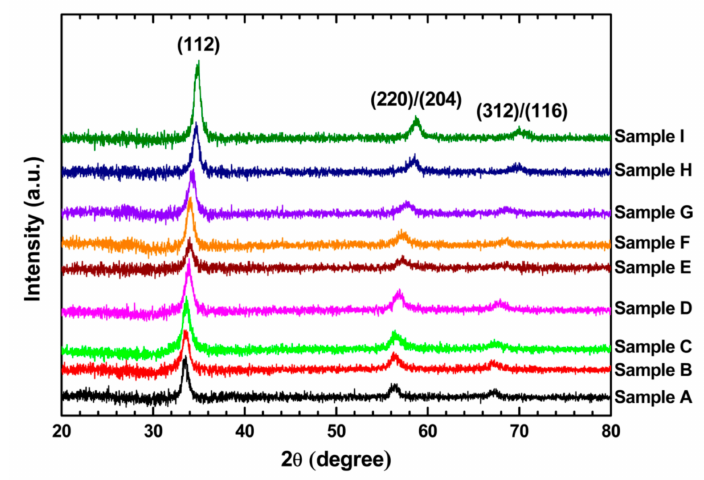
Figure 1. X-ray di ff raction patterns of CuIn 1 − x Ga x Se 2